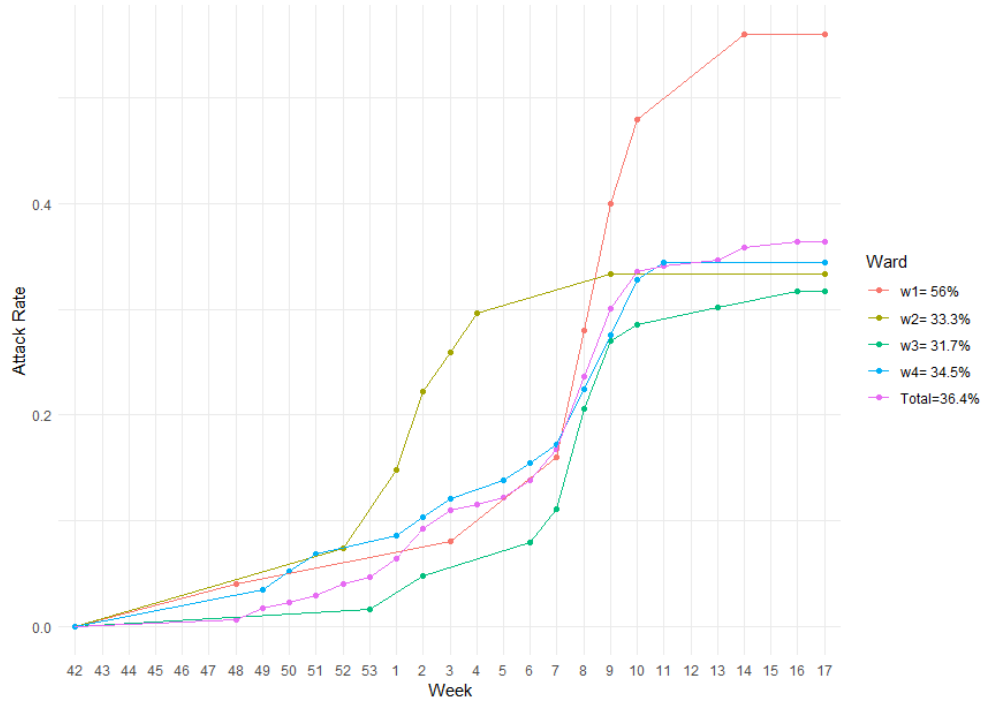
Figure 2. AR of the whole facility along with its wards during influenza season